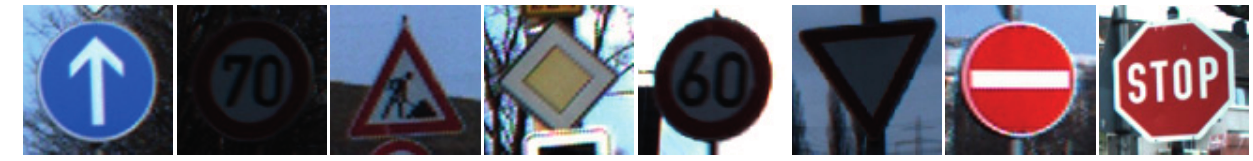
Figure 1. Different kinds of traffic signs from GTSRB data